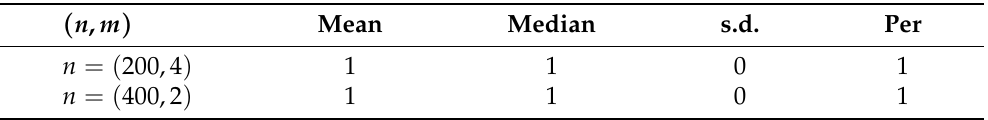
Table 5. The sample mean, median, and standard error (s.d.) of ˆ M and the empirical percentage (per) of ˆ M equal to the true number of subgroups M based on 100 replications in Example 3. ( n , m